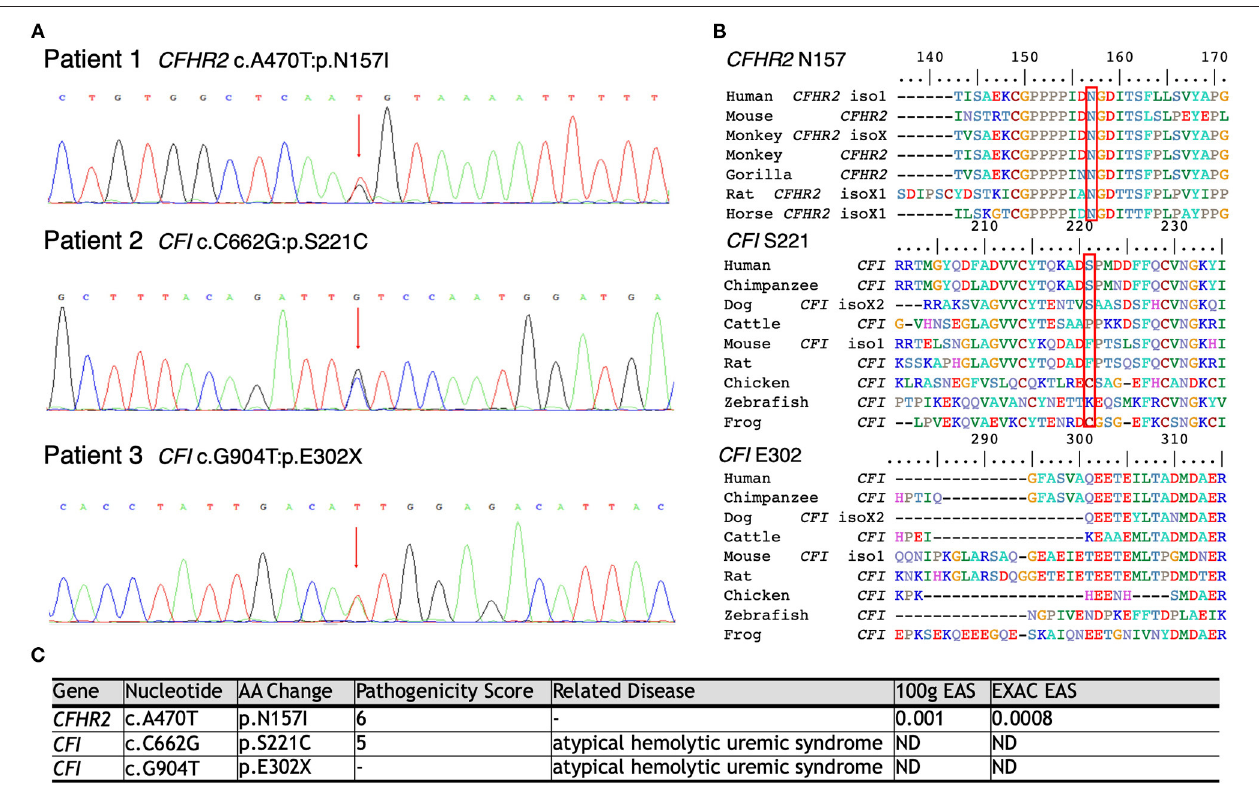
FIGURE 3 | Schematic model of the CFHR2 and CFI proteins and genes. (A) Genetic defects of complement genes in lupus patients with renal thrombotic microangiopathy. (B) The N157 of CFHR2 and S221 of CFI are highly conserved amino acids. (C) High pathogenicity score of CFHR2 N157I and of CFI S221C .